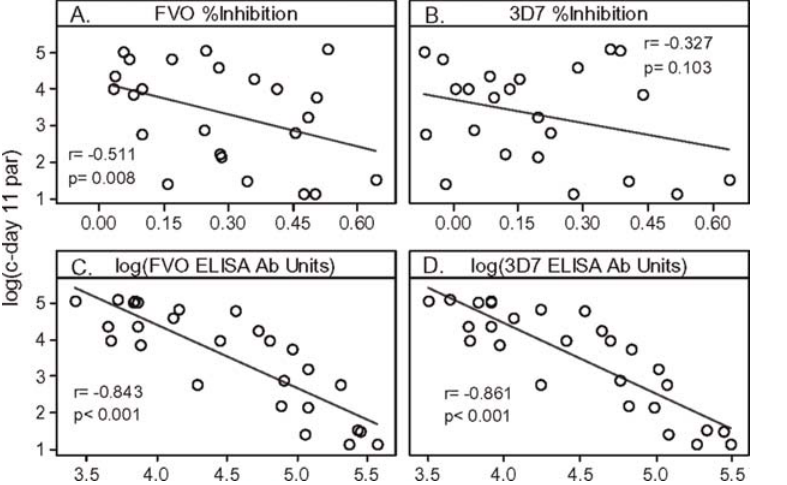
Figure 5. Correlation between log(c-day 11 parasitemia) and serologic response in animals vaccinated with FVO strain Ag. Animals were vaccinated with either E. coli or baculovirus expressed MSP1 42 in combination with FA, ISA-720 or AS02A. Growth/Invasion inhibition is against FVO (Panel A) or 3D7 (Panel B) strain targets. ELISA was performed with recombinant FVO (Panel C) or 3D7 (Panel D) strain MSP1 42 expressed in baculovirus. Correlations were determined with Pearson’s test after testing data distributions for